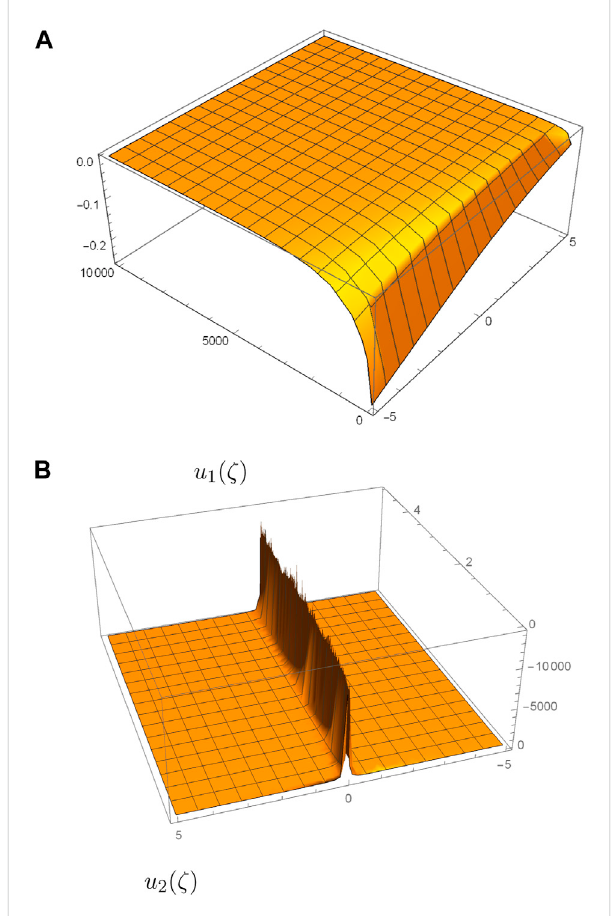
FIGURE 1 Three-dimensional plots of u1( ζ ) and u2( ζ ) in case 1 for η =0.5, w =1, ρ =1, s =1, l =1, L